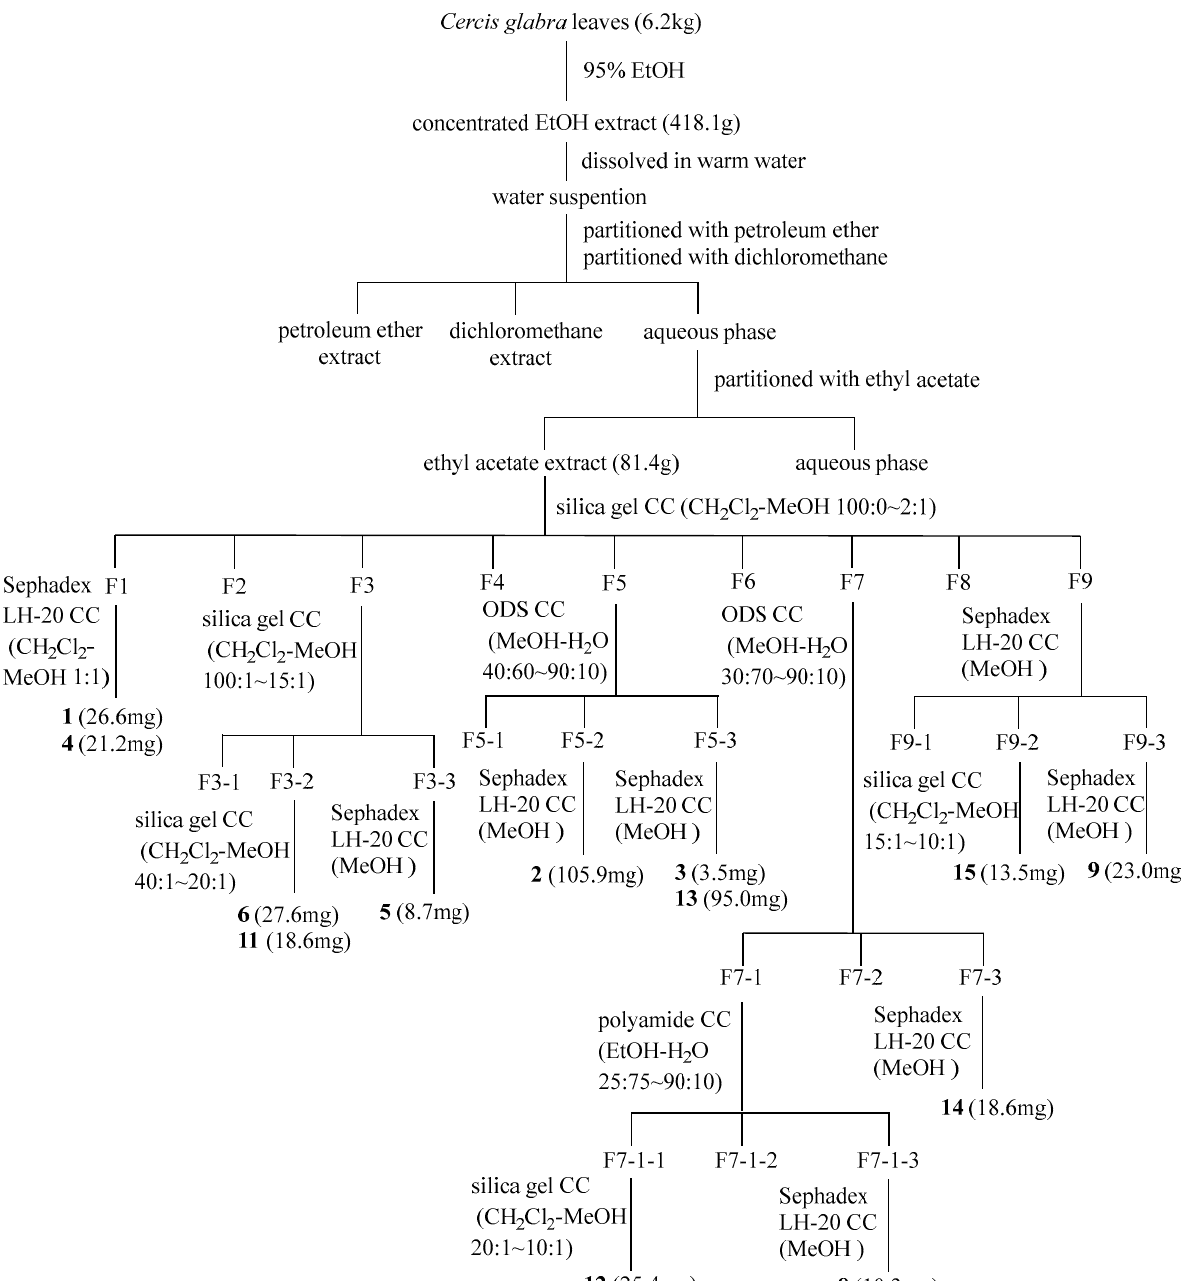
in Table 3. HR-ESI-MS m / z 325.0932 [M + H] + (calculated for C 15 H 17 O 8 ,